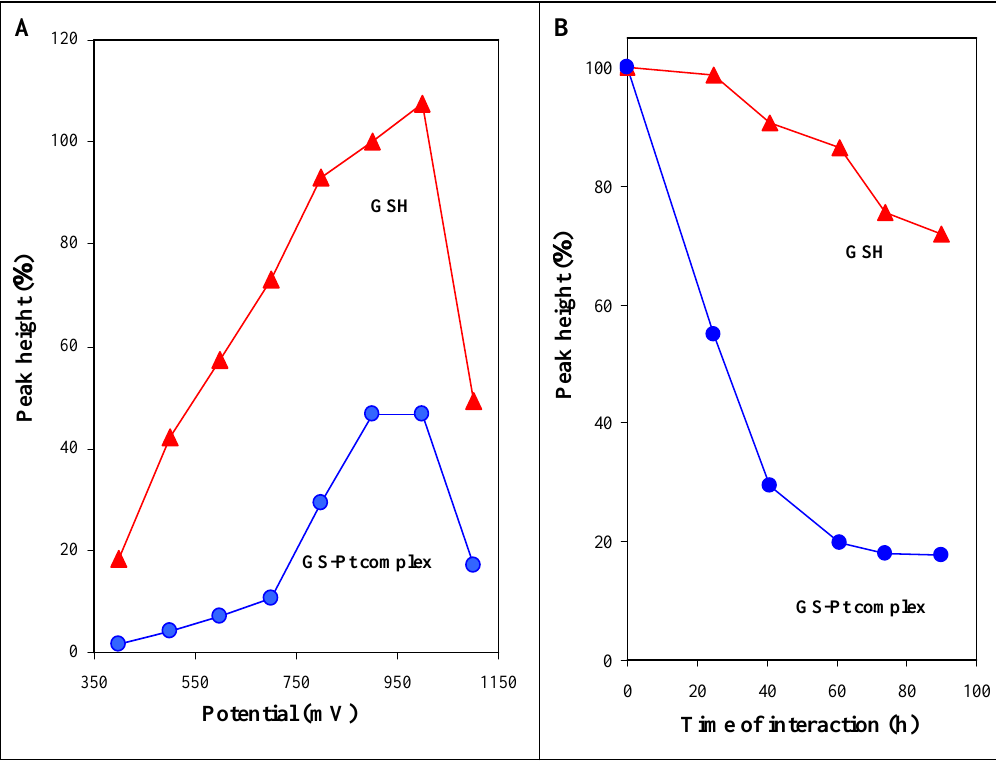
Figure 5. Hydrodynamic voltammograms of GSH and GS-Pt complex (1 µg mL -1 ) after 60 h long interactions ( A ). Dependences of height of GSH and GS-Pt complex on time and time of interaction, respectively ( B ). Signal of GSH of height 46.7 µA ( A ) and of height 1,620 µA ( B ) corresponds to 100 %. Cisplatin (30 µg mL -1 ) and GSH (60 µg mL -1 ) interacted in the presence of phosphate buffer (pH 7.8) in the dark at 37 °C. For other details see Fig.